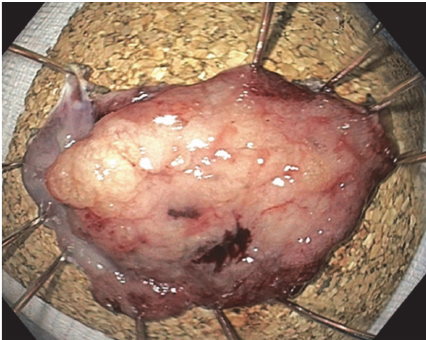
Figure 2: Lesion after endoscopic submucosal